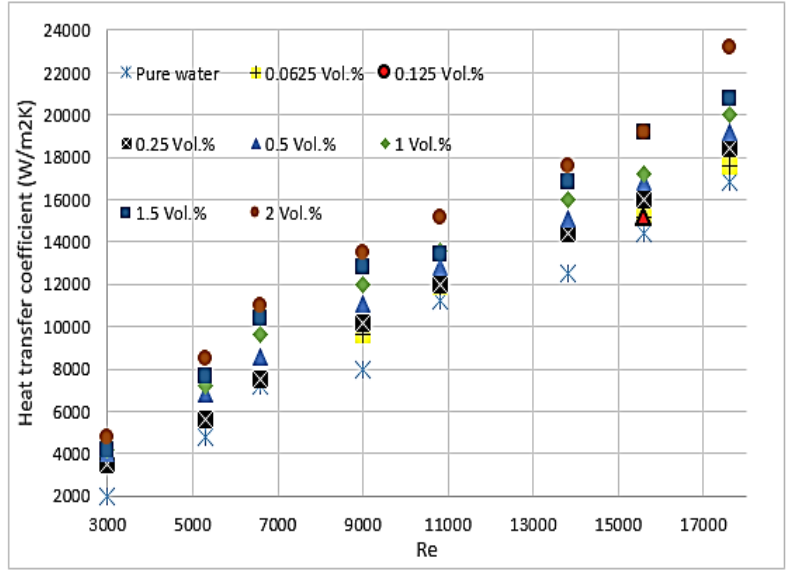
Figure 3. Heat transfer coefficient of CuO spherical nanoparticles with different concentrations ( ϕ ) under various Reynolds numbers. [68]